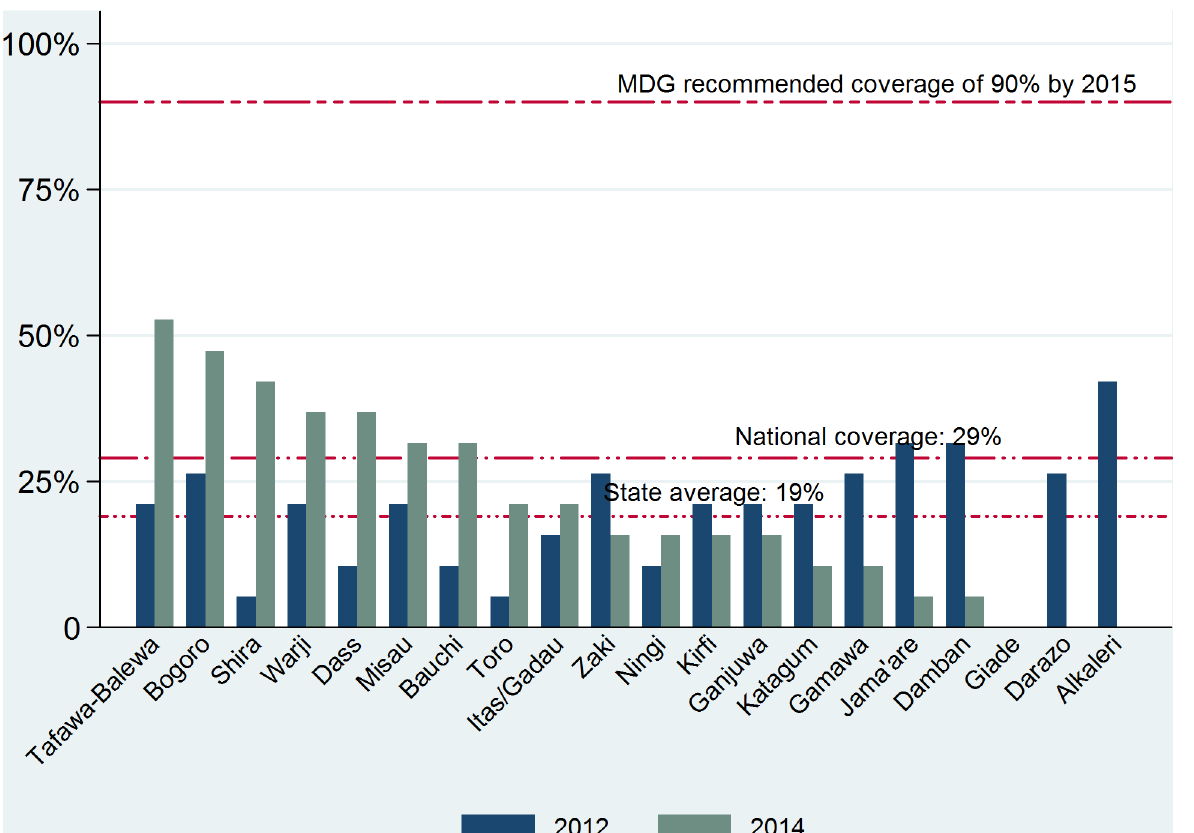
Fig 5. Early childhood: coverage of antibiotic use for pneumonia by LGAs, 2012 and